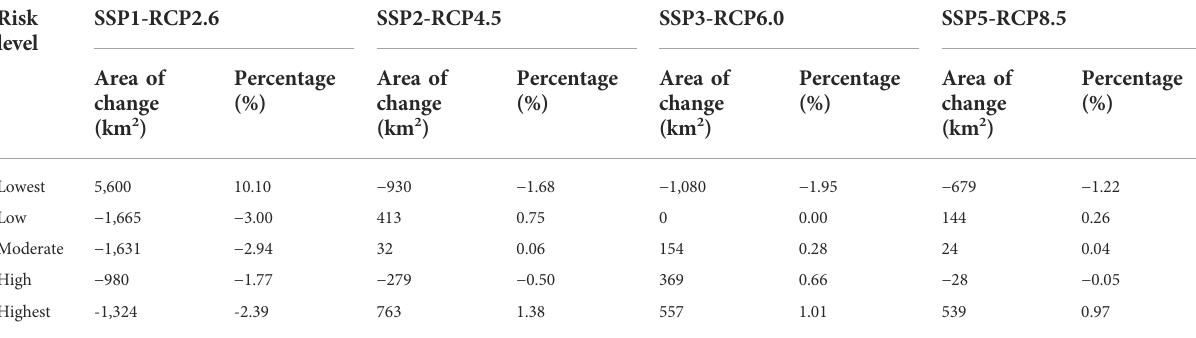
TABLE 7 Projected changes of fl ooding risk areas under four scenarios in 2050 compared with 2030. (Area of risk zones for different scenarios in 2050 minus the area of the corresponding risk zone for each scenario in 2030). Risk